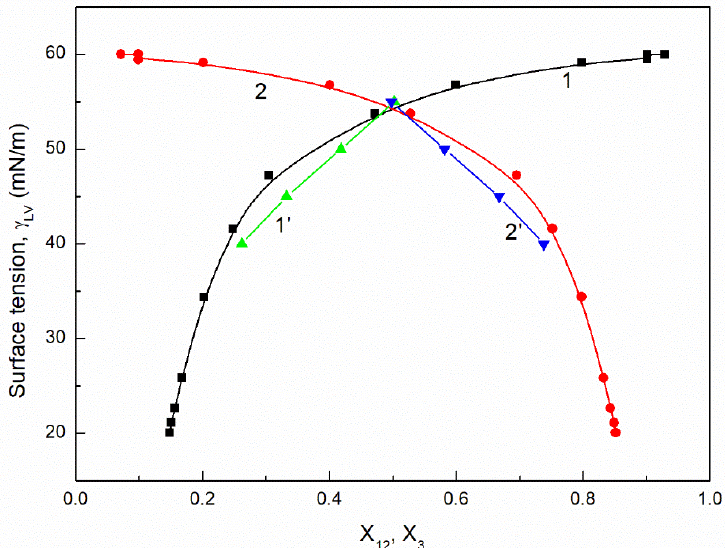
Figure 11. A plot of the surface tension ( γ LV ) of the aqueous solutions of CTAB + TX100 + FC2 mixture at the constant concentration of the binary mixture CTAB + TX100 ( C 12 ) and γ LV = 60 mN/m (m2 (60)) vs. the composition of the ternary mixture in the monolayer ( X 12 and X 3 ) determined based on the contribution of the particular surfactant in the mixture to the reduction of the water surface tension (curves 1 and 2) and calculated from Equation (5) (curves 1’ and 2’). X 12 corresponds to the sum of the CTAB ( X 1 ) and TX100 ( X 2 ) fractions and X 3 corresponds to the FC2